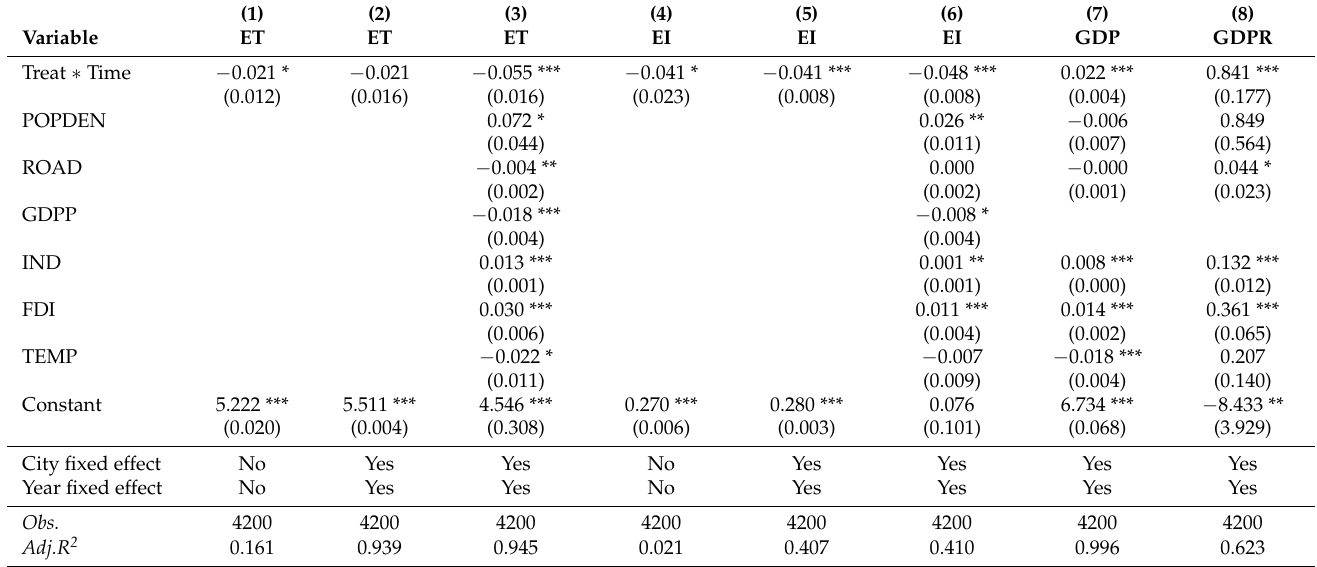
Table 2. Benchmark results of the effect of energy quota trading on energy